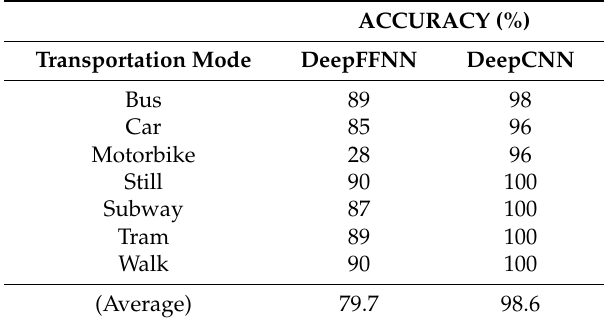
Table 5. Raw Data analysis approaches